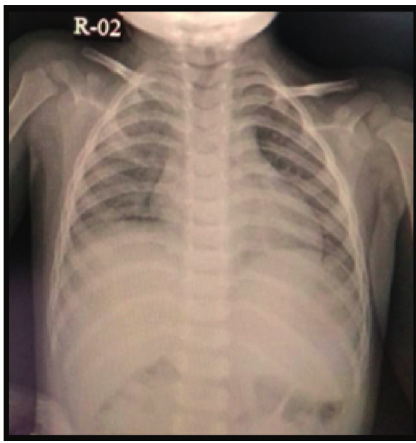
Figure 2: X-ray showing lung